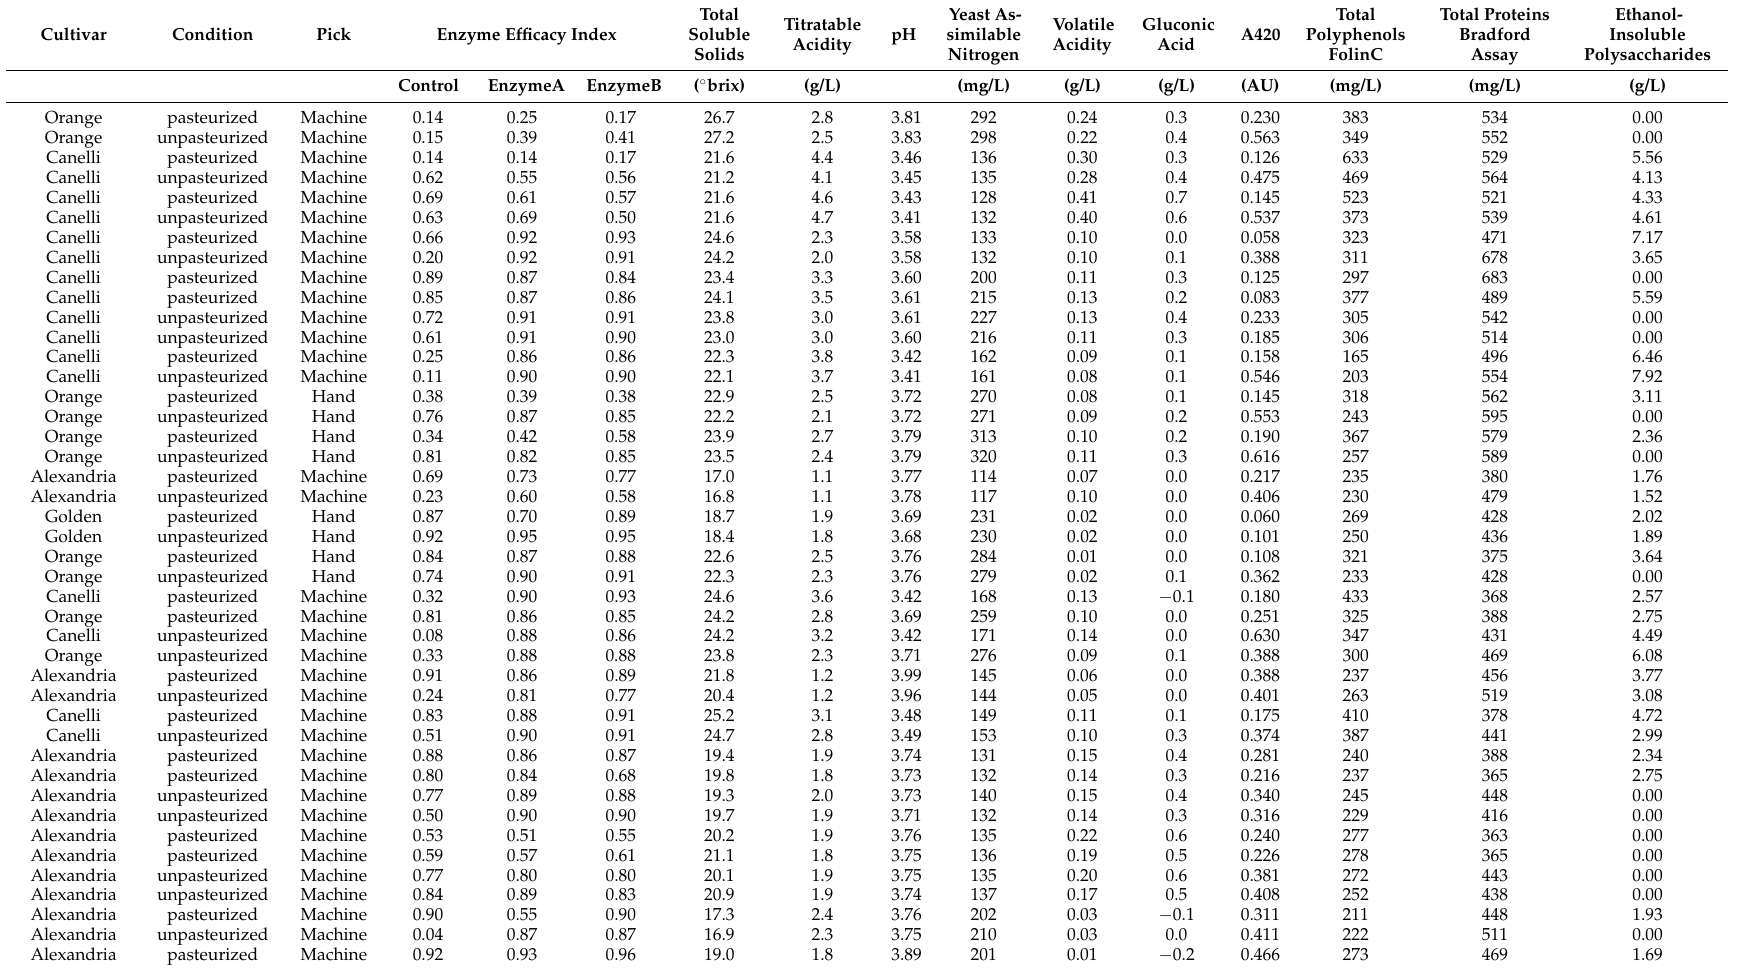
Table 1. All characterization data collected for pasteurized and unpasteurized Muscat juice samples in this